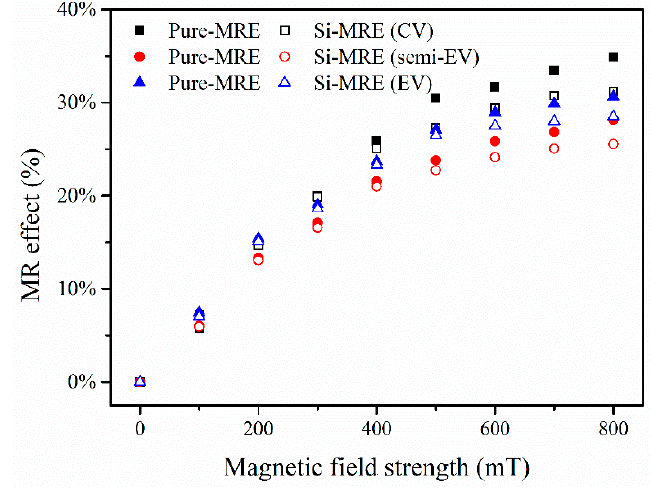
ff ect of the MRE and Si-MRE with various vulcanization Figure 8. Magnetorheological (MR) effect of the MRE and Si-MRE with various vulcanization systems. Figure 8. Magnetorheological (MR) e